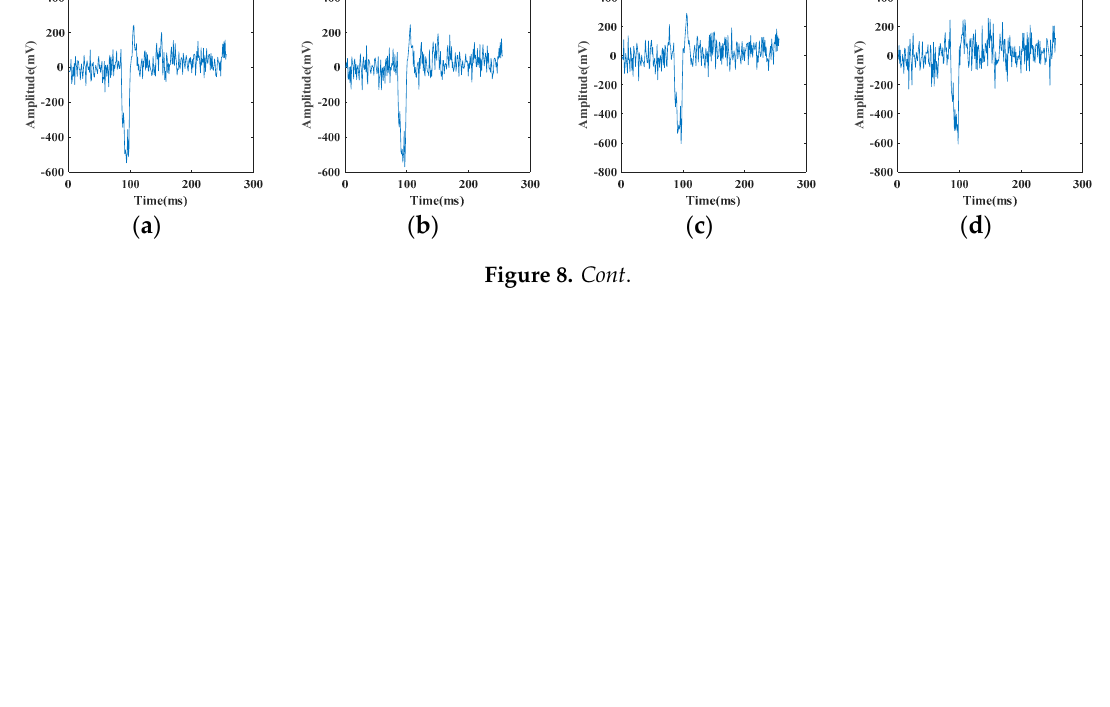
Table 1. Samples of training set and testing set